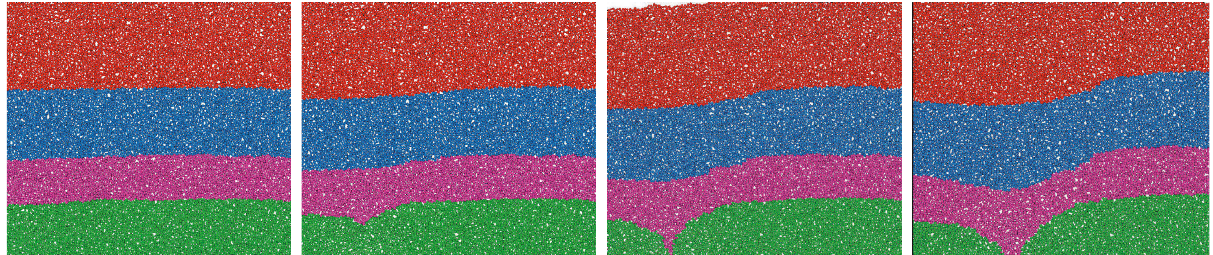
Figure 12: Migration characteristics of top coal during the simulation of “one cutting and one caving.”